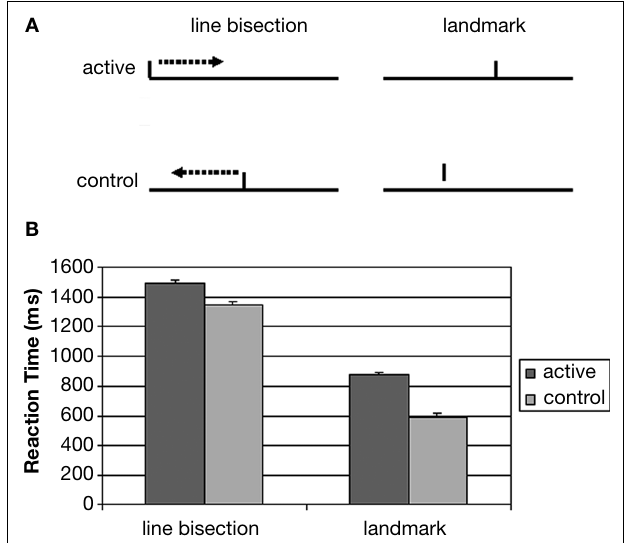
FIGURE 1 | (A) Landmark task stimuli consisted of prebisected lines and subjects were required to judge whether they were correctly bisected or not . In the Landmark control condition subjects were presented either lines with adjacent or separate mark and the instruction was to judge whether the mark touched the line or not. In the Line Bisection task subjects were presented by a line with a cursor on the left or right edge and they moved the cursor to the center. In the line bisection control cursor appeared at the center of the lines and subjects were to move it to the edge of the line. (B) Average group reaction times for Landmark and Line Bisection tasks (for active and control